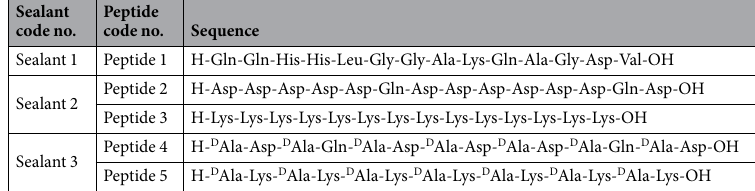
Table 1. Designed sealants and peptide